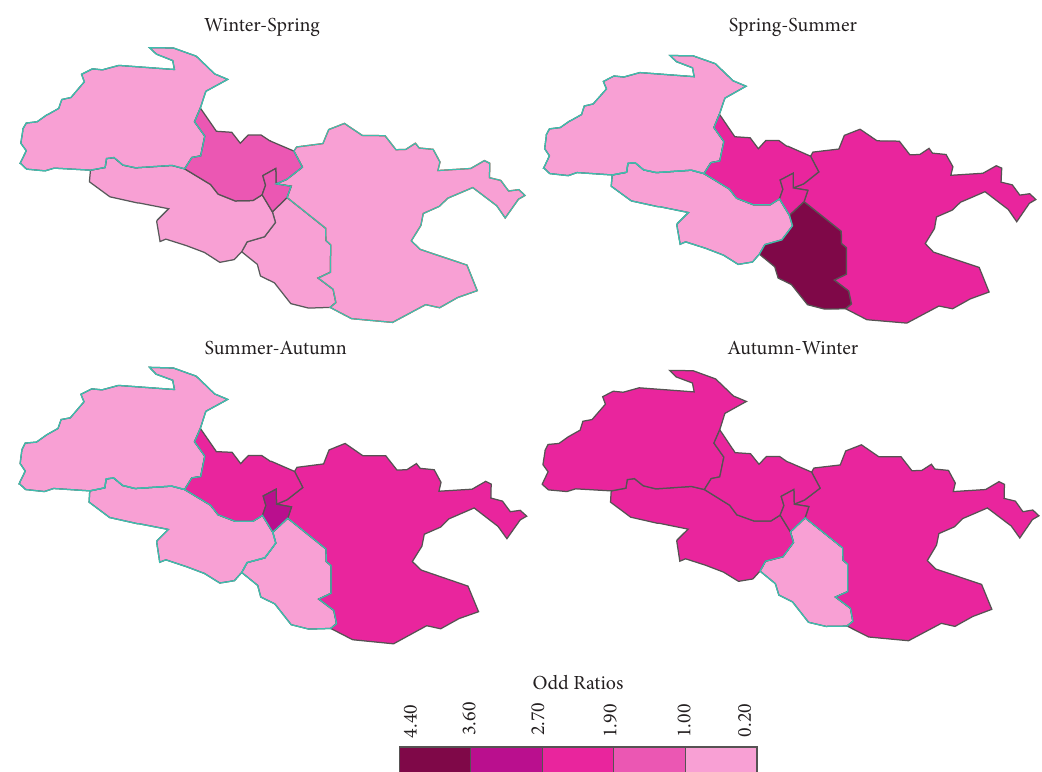
Figure 9: Odds ratio for various seasons in the selected stations. The relationship in the bolded stations is significant at α < 0 .